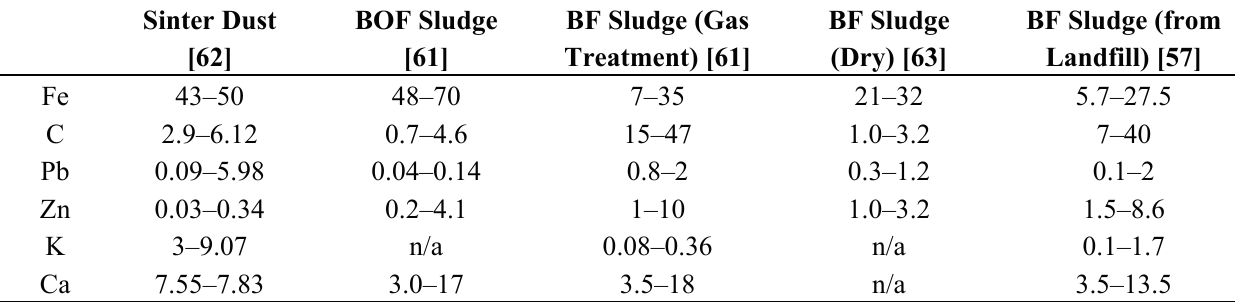
Table 3. Typical composition of key constituents of steel wastes (mass